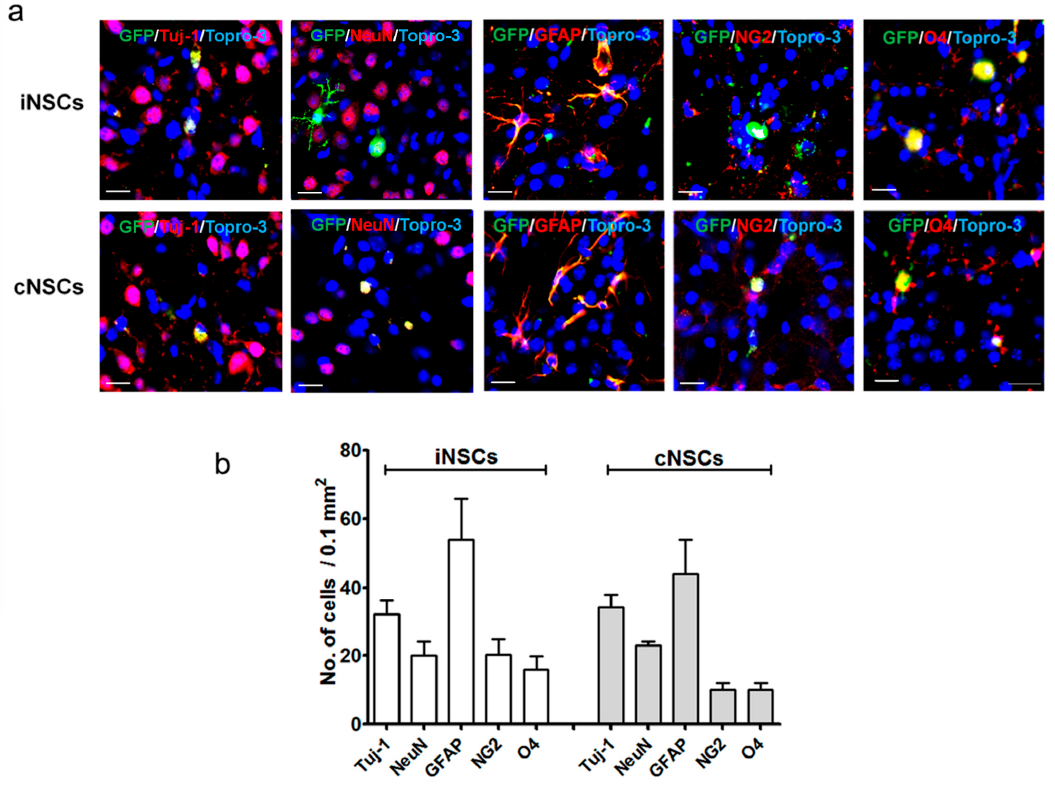
Figure 4. Differentiation into all neuronal lineages of engrafted iNSCs ( a ) Representative photomicrograph of GFP-positive iNSCs and cNSCs differentiated into both the neuronal and the glial lineages in vivo as determined by co-staining with Tuj-1 or NeuN (red) for neurons, GFAP or NG2 for astrocytes, and O4 for oligodendrocytes, respectively in the striatum at 12 weeks after transplantation. Blue colors show Topro-3 nuclear marker. Scale bars = 20 µm; ( b ) results are presented as triple stained cell counts per 0.1 mm 2 areas ( n = 6).